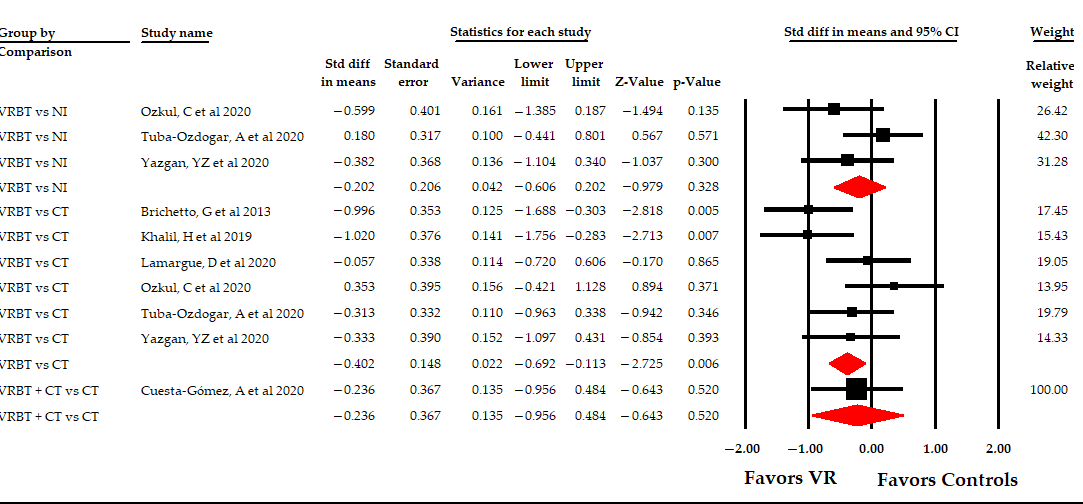
Sensors 2021 , 21 , x FOR PROOFREADING 10 of 20 Figure 3. Subgroup Analysis of the Effect of Virtual Reality on Fatigue According to Specific Comparisons.